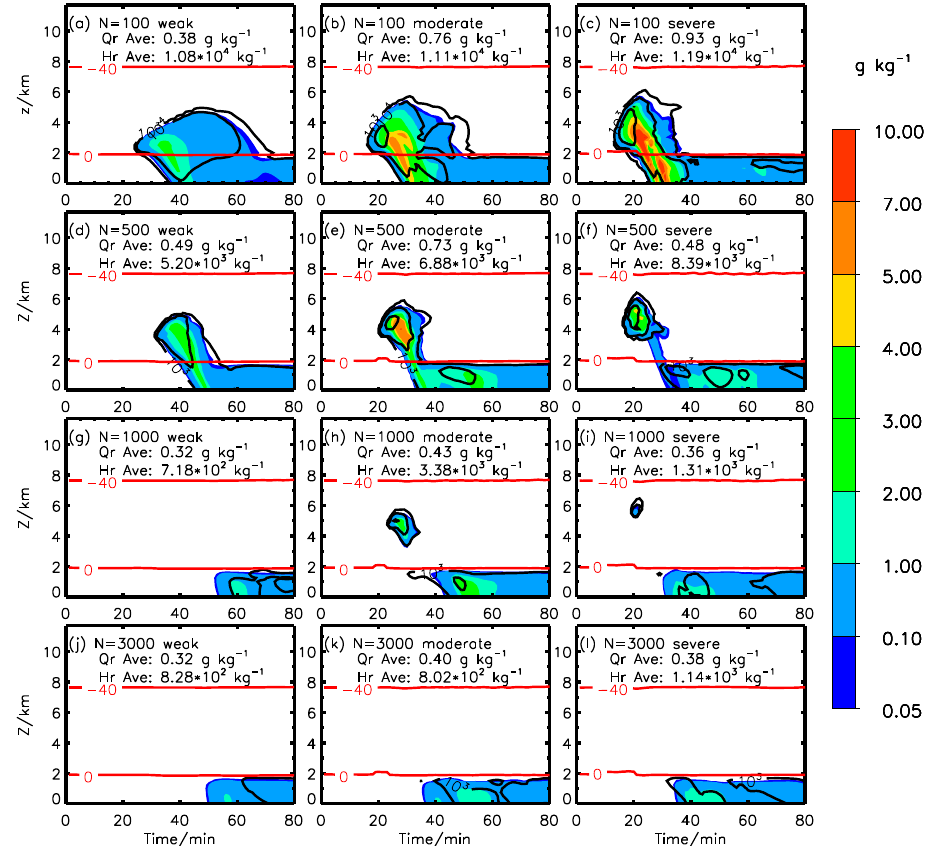
Figure 5. Spatial and temporal distribution of the mixing ratio and the number concentration of raindrop for initial aerosol concentrations: ( a – c ) 100 cm − 3 , ( d – f ) 500 cm − 3 , ( g – i ) 1000 cm − 3 , ( j – l ) 3000 cm − 3 ; the red solid line represents the isotherm ( − 40 and 0 °C); the black contour respectively represents: 10 3 , 10 4 , 10 5 , and 10 6 kg − 1 .